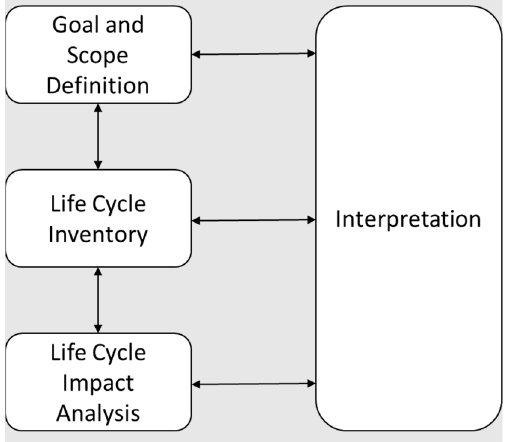
Figure 1. The four phases of life cycle assessment.